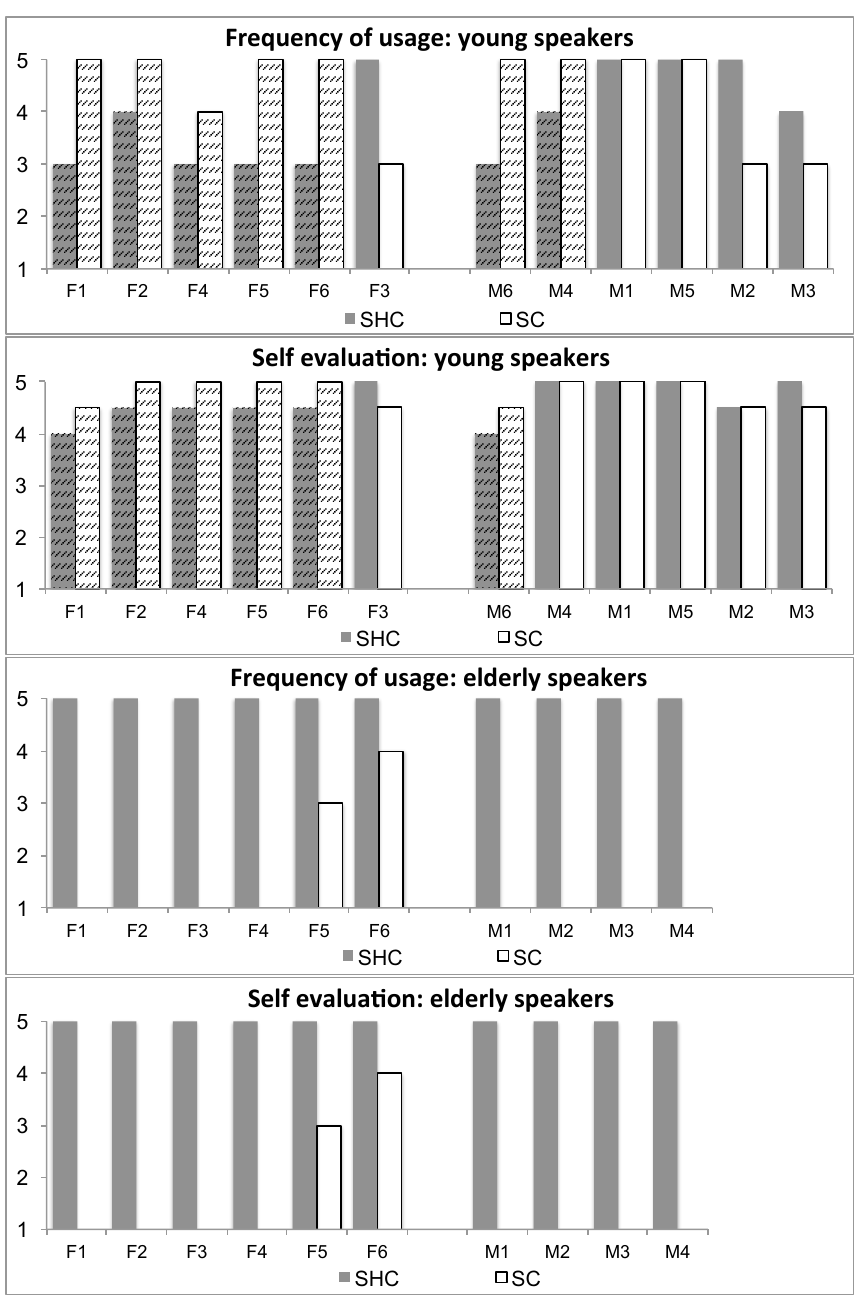
Figure 8 : Individual results of frequency of usage and self-­‐evaluation in Shanghai Chinese (SHC) and Standard Chinese